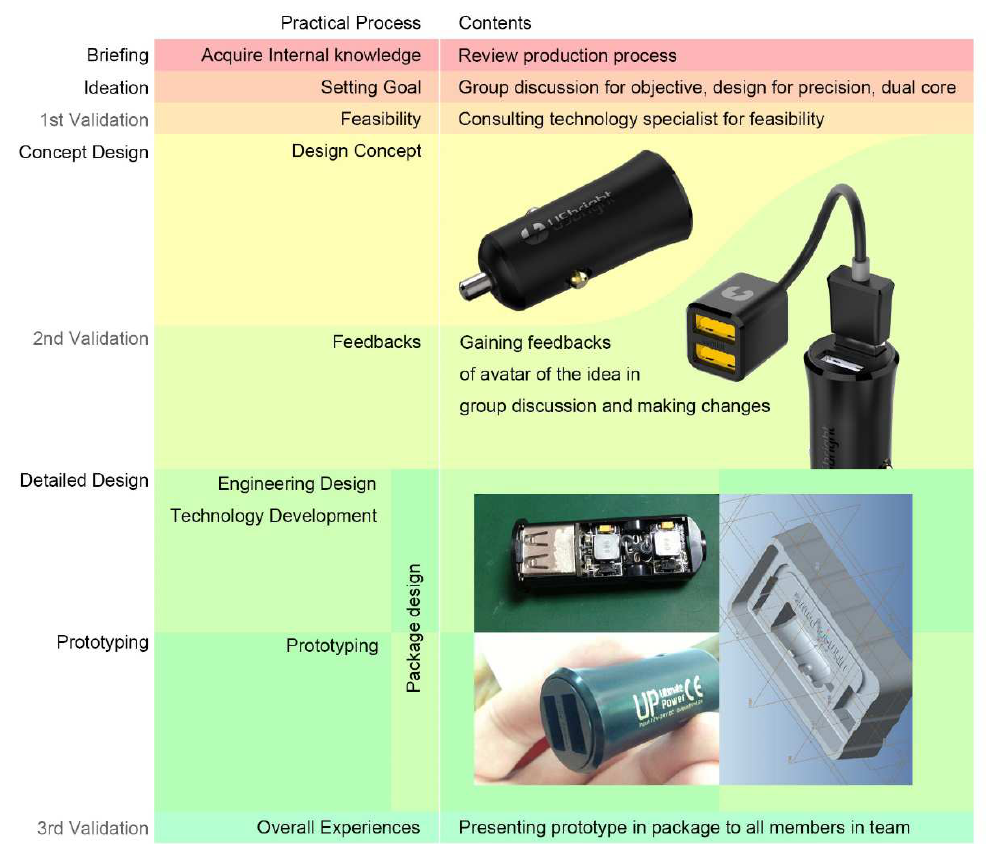
Figure 6: Designer-led NPD Team Practical Application